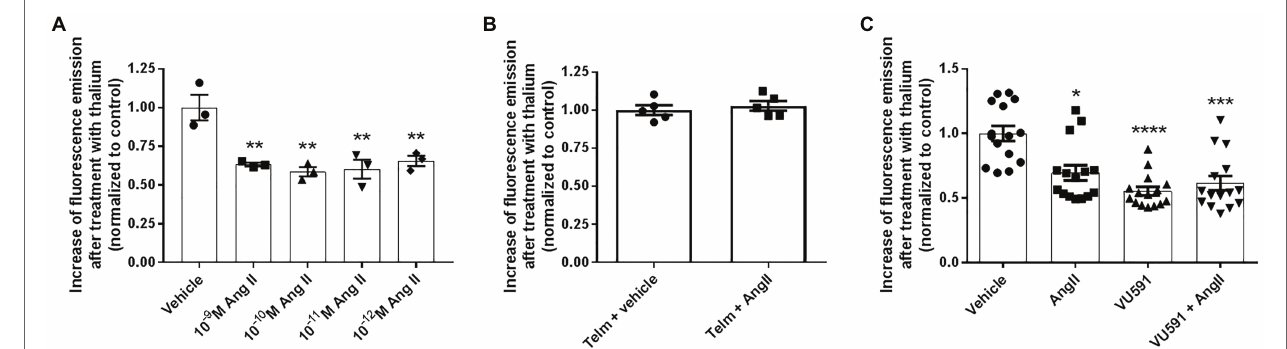
FIGURE 2 | Angiotensin II (Ang II) inhibits ROMK-mediated K + conductance in M-1 cells. (A) M-1 cells were treated with different Ang II concentrations or vehicle for 30 min ( n = 3). ** p < 0.01 vs. vehicle-treated M-1 cells. The p value was calculated using ANOVA followed by the Bonferroni post hoc test. (B) M-1 cells were pretreated with telmisartan for 60 min and then treated with vehicle or Ang II (10 −10 M) for 40 min. (C) M-1 cells were treated with Ang II (10 −10 M) or vehicle in the presence or absence of the selective ROMK inhibitor VU591 (10 μ M) for 40 min ( n = 15). * p <0.05; *** p <0.001; **** p <0.0001 vs. vehicle-treated M-1 cells. The p value was calculated by using the Kruskal-Wallis test, followed by Dunn’s post hoc